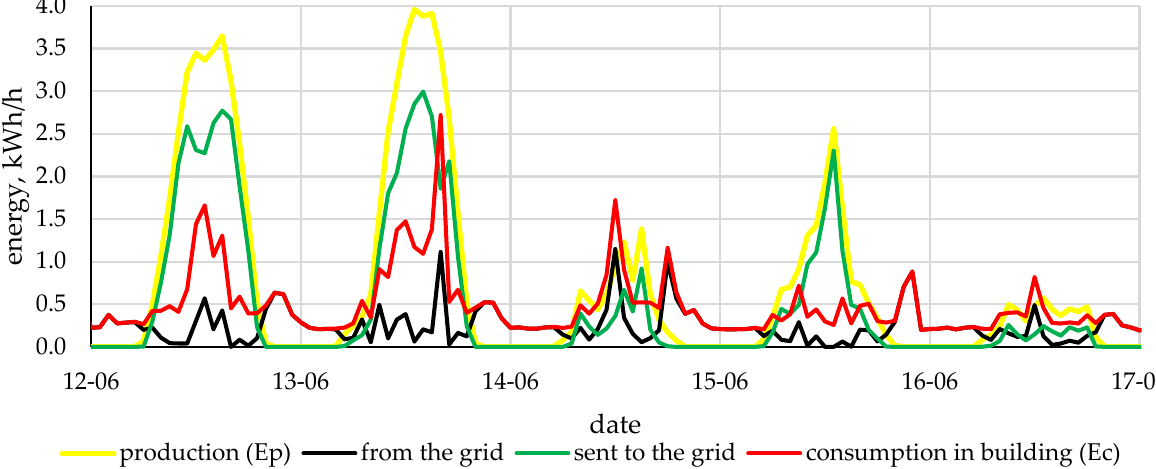
Figure 8. Energy production in the PV installation Leki and energy: added to the grid, consumed and Energy consumption in the building, June 2020.